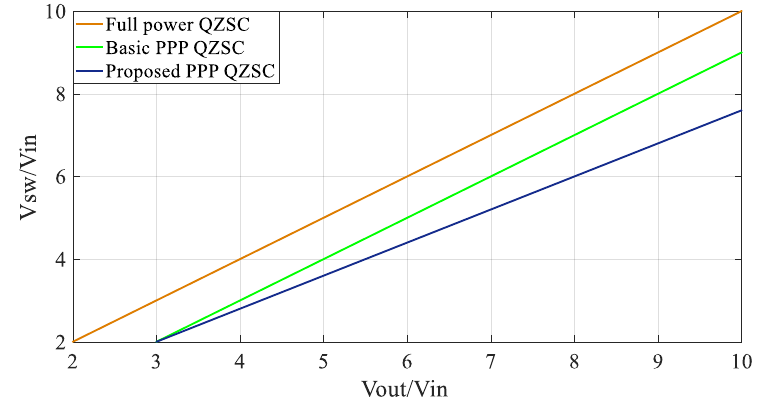
Figure 7. The effect of non-idealities on output voltage waveform versus duty cycle for the three discussed converters.